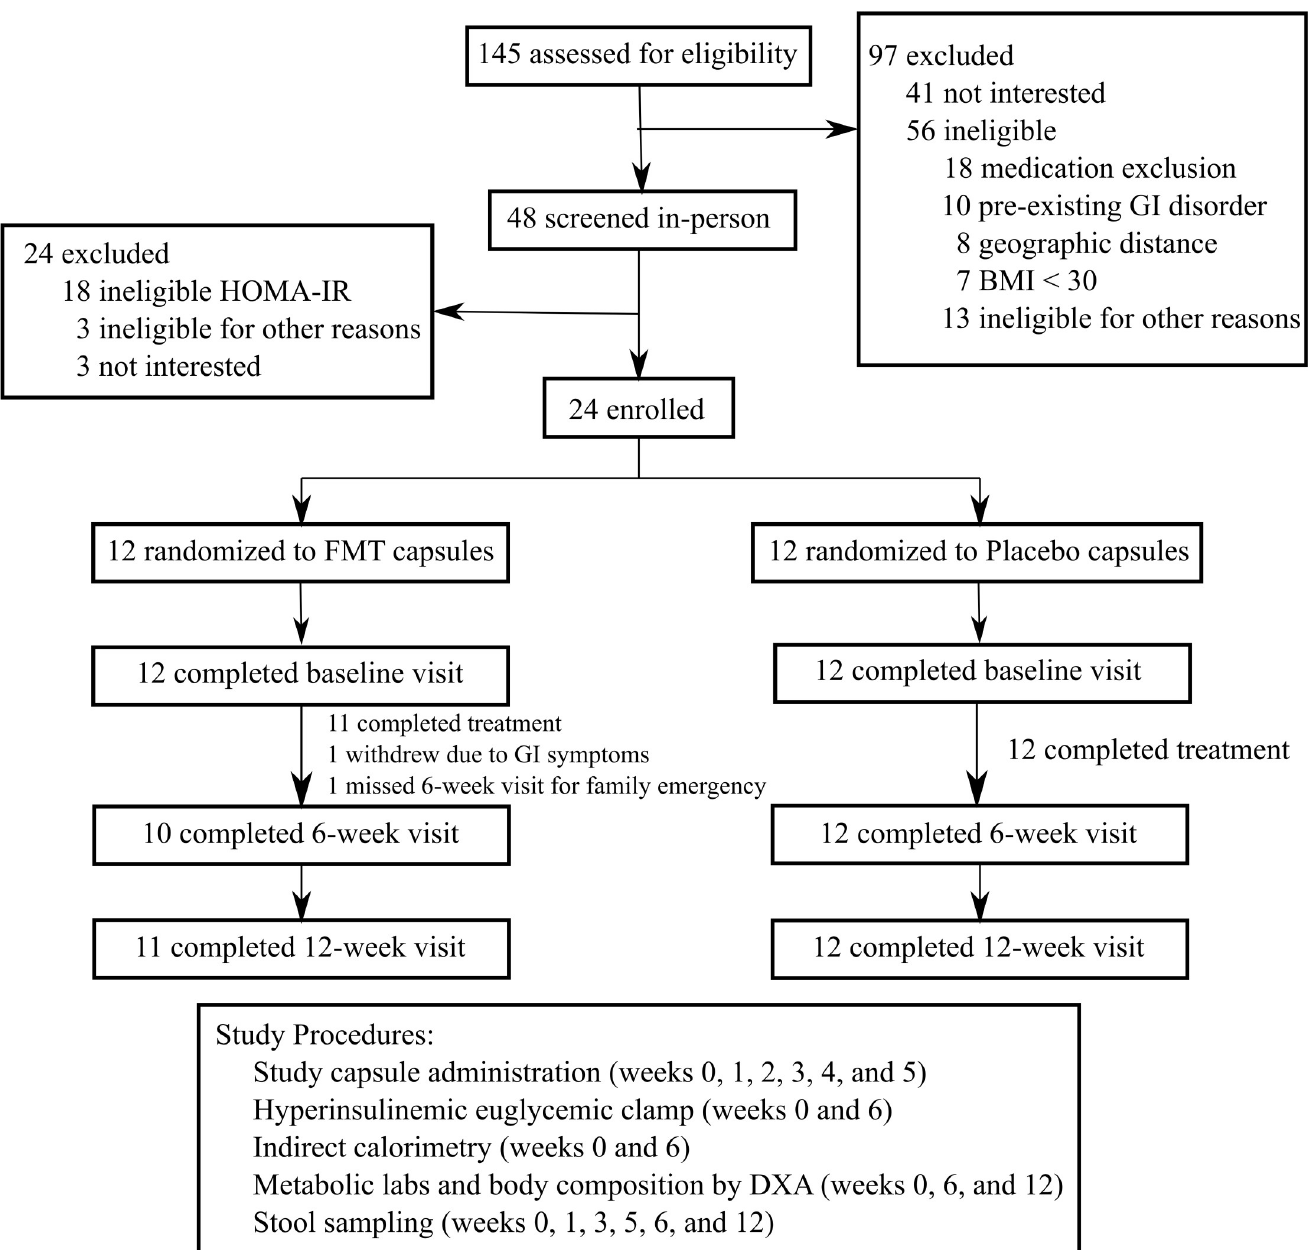
Fig 1. Study flow diagram. DXA, dual-energy X-ray absorptiometry; FMT, fecal microbiota transplantation; GI, gastrointestinal; HOMA-IR, homeostatic model assessment of insulin resistance.